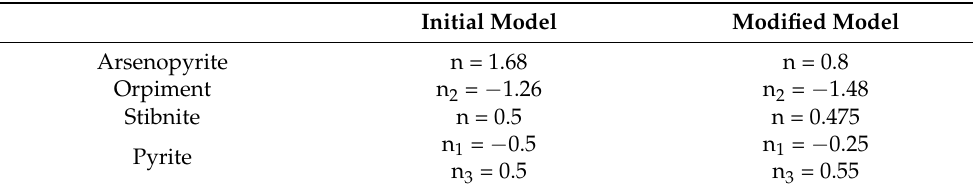
Table 16. Modification of the first kinetic model. n x : representing the index used in the rates equation (Appendix